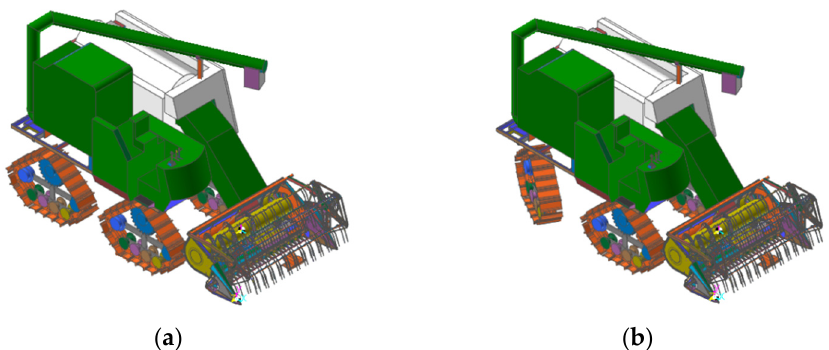
Figure 8. Virtual prototype model: ( a ) differential steering chassis and ( b ) rear axle steering